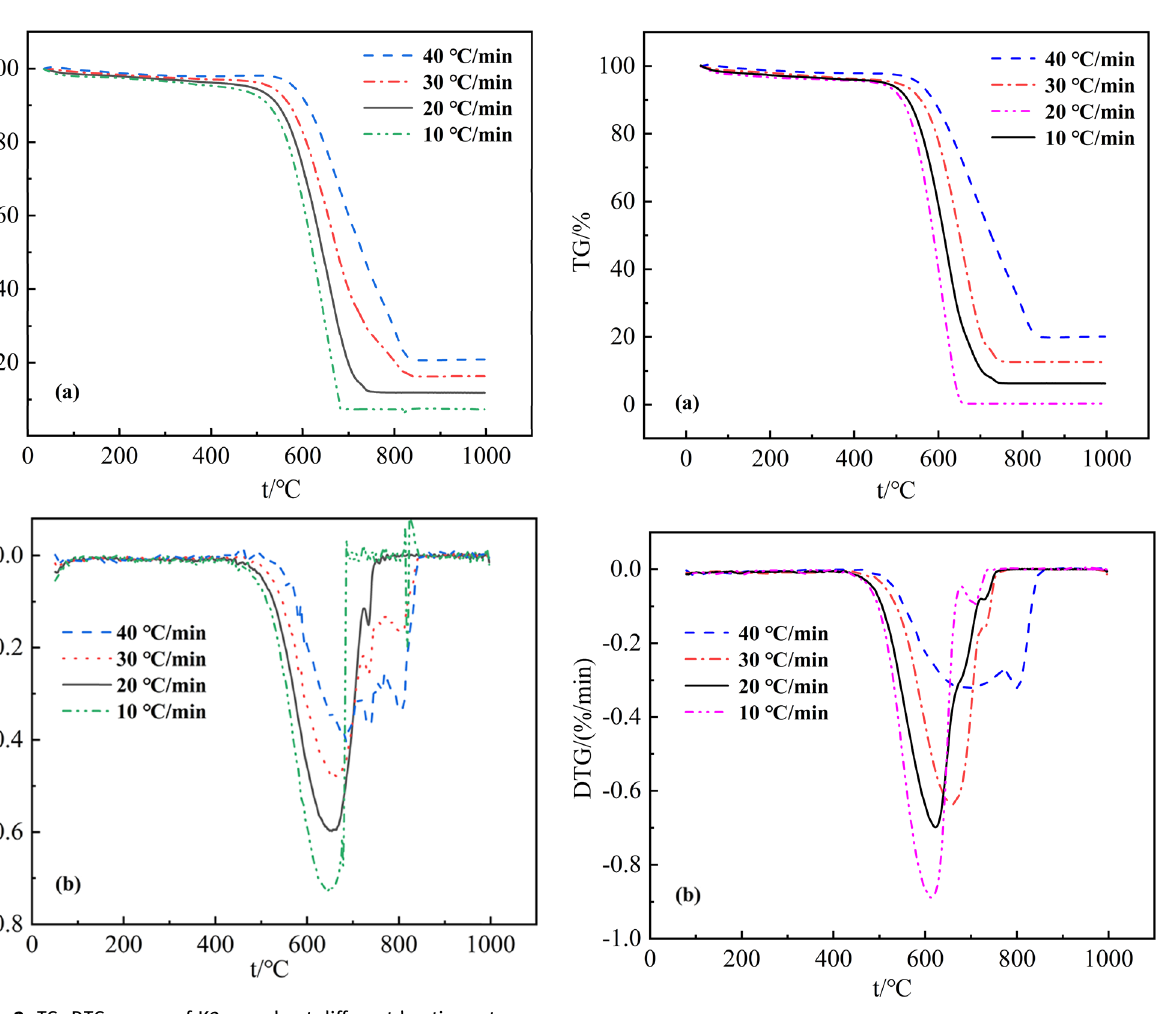
Figure 3: TG – DTG curves of K2 sample at di ff erent heating rates: ( a ) TG and ( b ) DTG curves. Figure 4: TG – DTG curves of K3 sample at di ff erent heating rates: ( a ) TG and ( b ) DTG